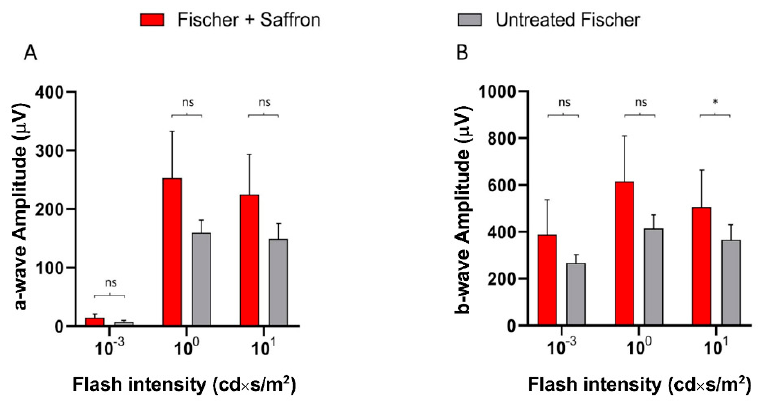
Figure 7. ERG response in saffron treated and untreated Fischer rats. ( A ) A-wave amplitude at three luminances (0.001 cd×s/m 2 , 1 cd×s/m 2 , 10 cd×s/m 2 ) in treated (red) and untreated (grey) rats. ( B ) B-wave amplitude at three luminance in treated (red) and untreated (grey) rats. B-wave amplitude is statistically significant only at high intensity flash (10 cd*s/m2. ( n = 3; mean ± SEM; Statistical tests: One way ANOVA followed by Dunnett’s test) significance indicator: * p < 0.05. 3.3. Aging In the physiological senescence processes, the mechanisms that trigger cell malfunction and, eventually, degeneration have a much slower progression than in diseases such as RP which have relevant genetic components, or in age-related multifactorial diseases. For this